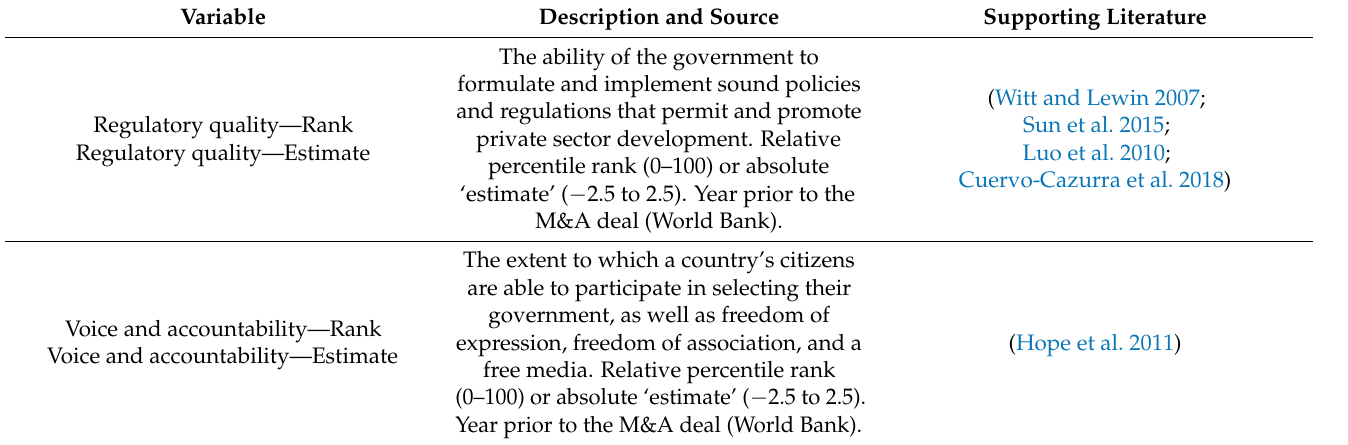
Table A3. Independent and control variables (descriptions, measures, and